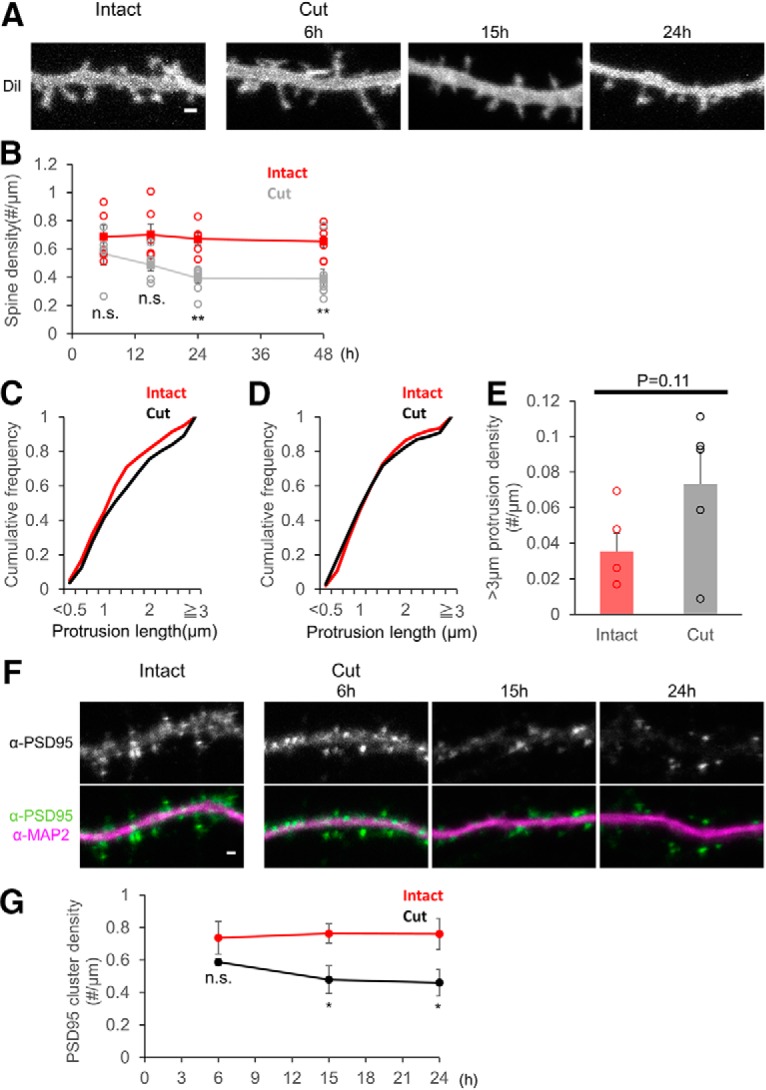
Time course of changes in spines after afferent axon cutting. A, Confocal images of dendrites stained with DiI without afferent elimination (intact), or 6, 15, and 24 h after afferent elimination (cut). B, Spine density at 6, 15, 24, and 48 h after afferent elimination. C, D, Cumulative frequency of spine lengths at 6 h (C) and 24 h (D) after afferent elimination. Spines after elimination of afferent axons showed a tendency to be longer than those in intact cells at 6 h. E, Average densities of dendritic protrusions classified as long protrusion (>3 µm) in intact neurons or in neurons 6 h after afferent elimination. F, Confocal images of dendrites immunostained with PSD-95 and MAP2 antibodies without afferent elimination (intact), or 6, 15, and 24 h after afferent elimination (cut). The upper row shows images of anti-PSD-95 immunofluorescence. The lower row shows merged immunofluorescence images of anti-PSD-95 (green) and anti-MAP2 (magenta). G, Average densities of PSD-95 clusters along each dendrite at 6, 15, and 24 h after afferent elimination. Error bars are SEM; *p < 0.05, **p < 0.01, n.s. = not significant. Scale bars = 1 μm. Evaluation of damage by afferent axon elimination can be found in Extended Data Figure 2-1.